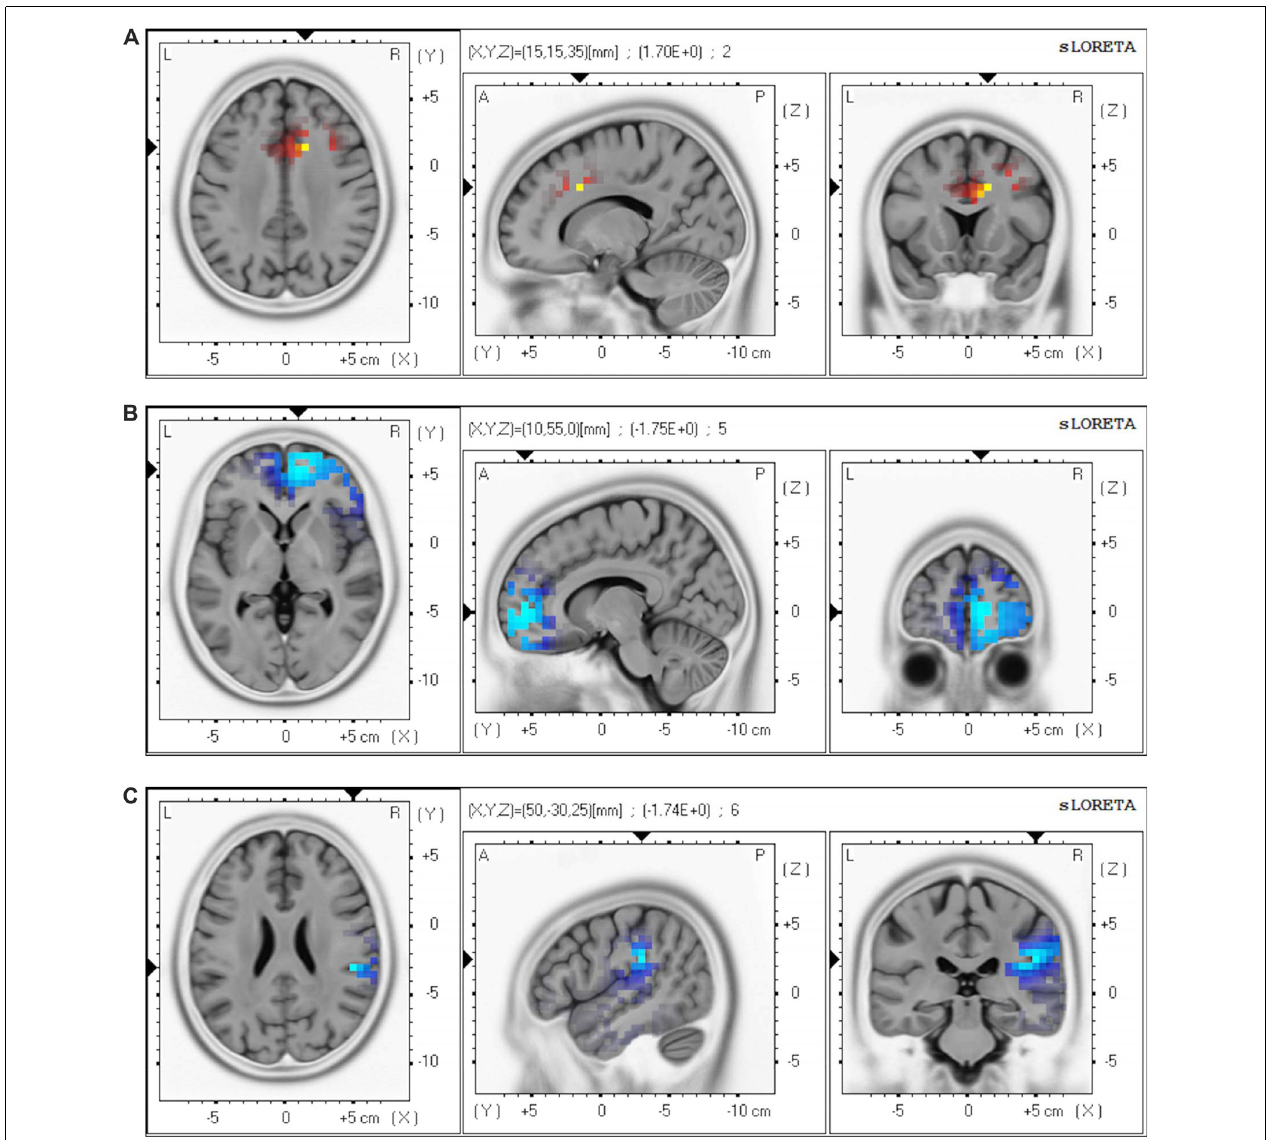
FIGURE 1 | Brain regions showing change in oscillatory patterns after a course of electroconvulsive therapy (ECT). Our analyses revealed the following changes after ECT: (A) increased theta (4.0–7.5 Hz) in the anterior cingulate cortex (ACC) and the medial prefrontal cortex (MPFC); (B) decreased beta 2 (20.5–30.0 Hz) in the frontal pole (FP); and (C) decreased gamma (30.5–45.0 Hz) in the right inferior parietal lobule (IPL). Red regions correspond to significantly increased CSD after ECT, and blue regions correspond to significantly decreased CSD after ECT. Abbreviation: CSD, current source